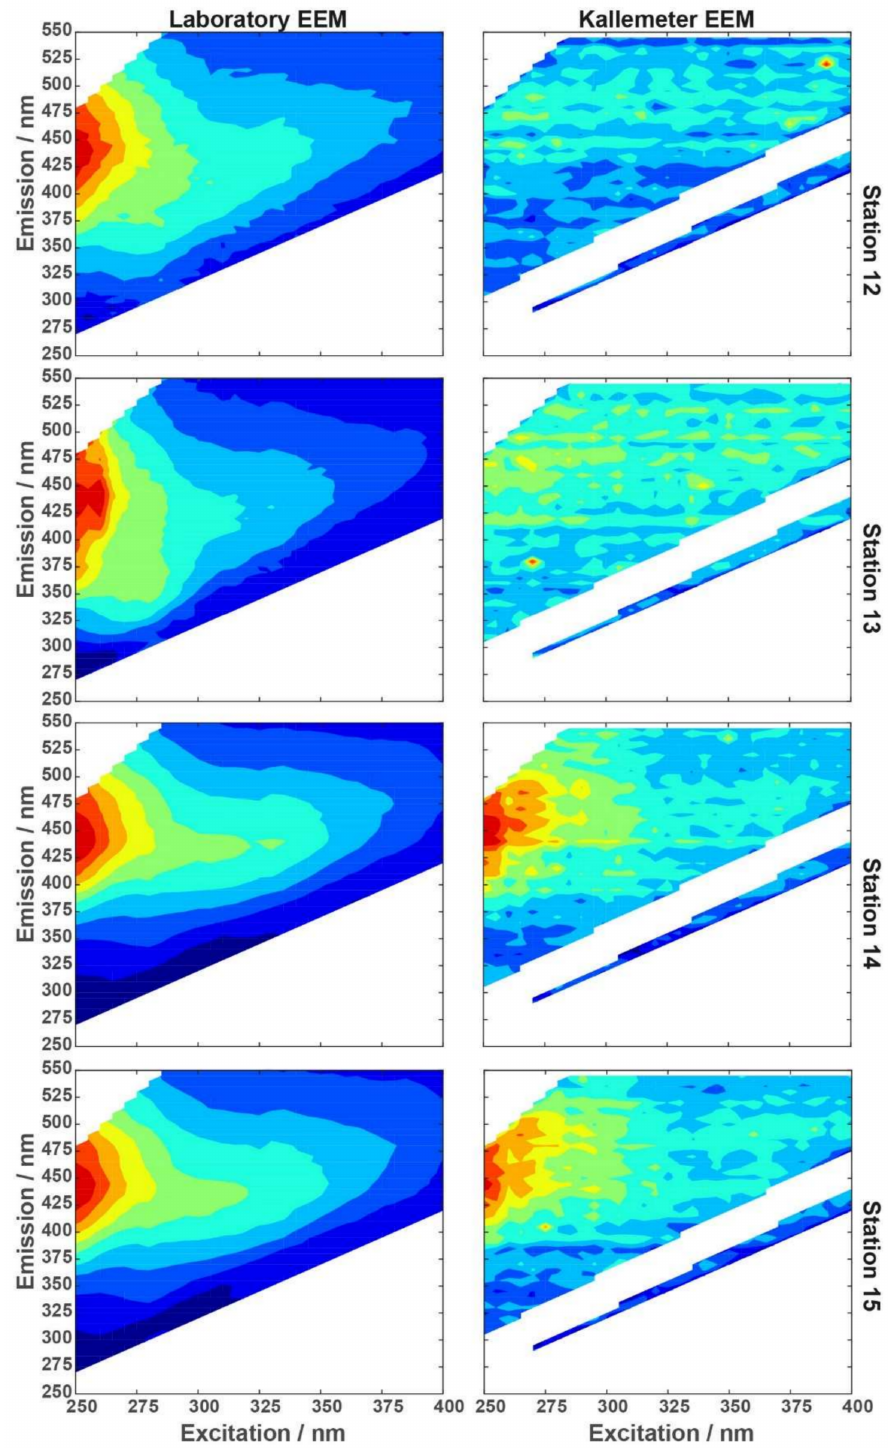
Figure 10. Normalized EEM spectra from lab-based water sample analysis with the LS55 laboratory spectrofluorometer ( left ) and nearby (match-up of ± 1 h) in situ measurements with the Kallemeter ( right ) for stations 12–15 of R/V Heincke expedition HE491 along a transect from the coastal ocean into the Trondheimsfjord. Notice that FDOM intensity in stations 14 and 15 are 5-times higher compared to stations 12 and